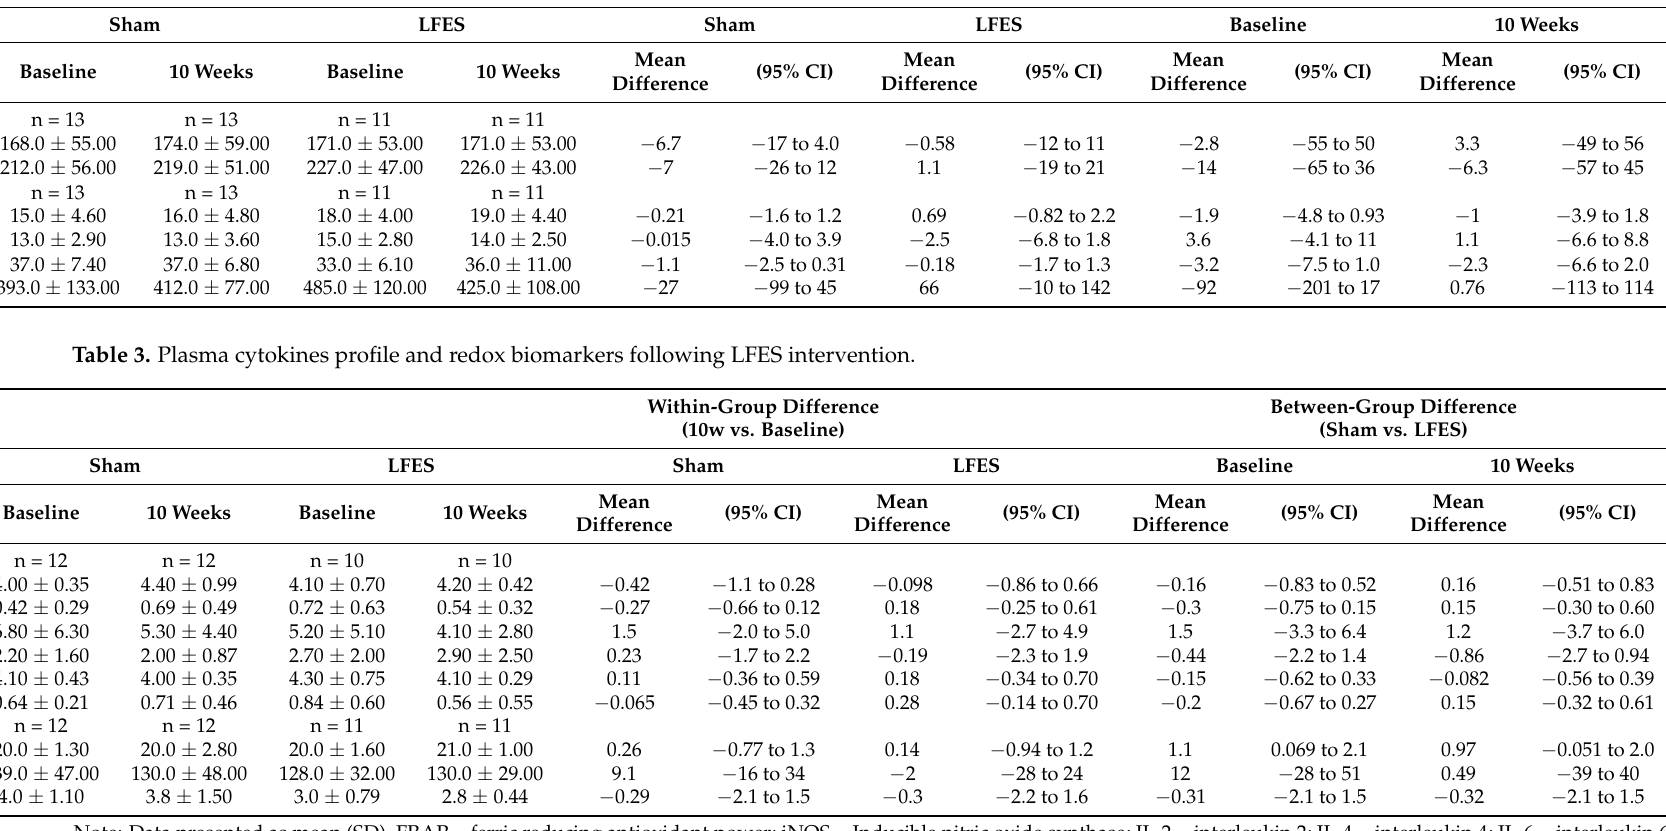
Table 2. Cardiopulmonary capacity and muscle strength following LFES intervention. Within-Group Difference Between-Group Difference (10w vs. Baseline)